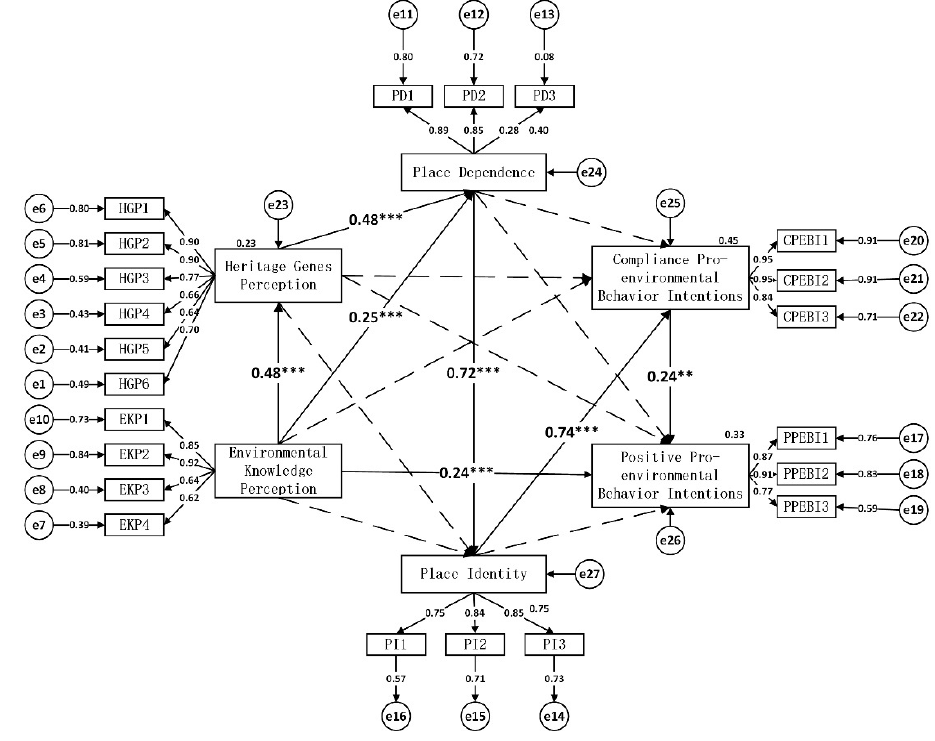
Figure 3. Results of the hypotheses test. ** p < 0.01, *** p < 0.001. Table 7. Results of hypotheses test. ** p < 0.01, *** p < 0.001. Hypothesised Relationship